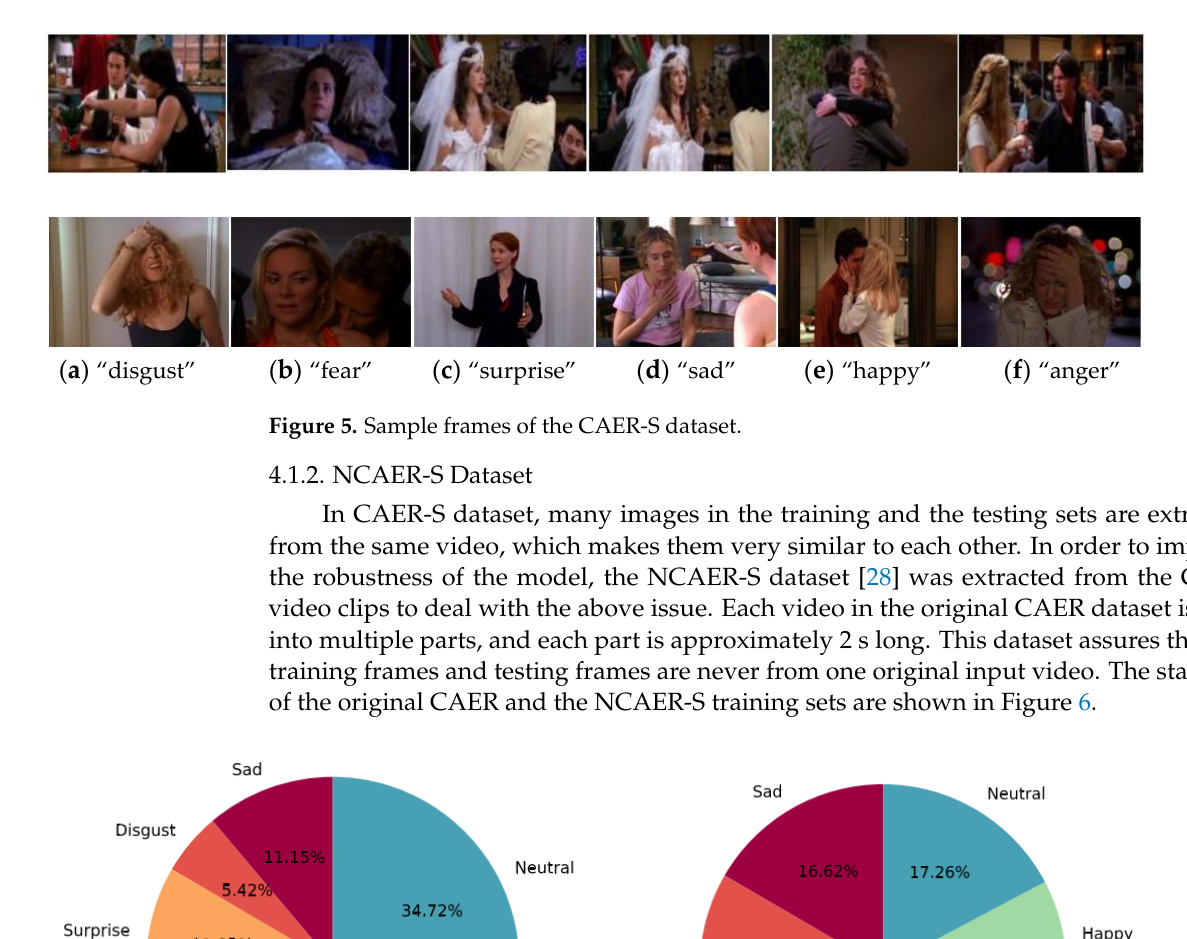
Figure 7. The accuracy curve of MCF-Net on CAER-S dataset. The loss function curve of the MCF-Net obtained during the training process is shown in Figure 8, where the red line represents the training loss, and the blue line means the validation loss. It can be concluded that both training loss and validation loss of our model gradually decrease and begin to converge around the epoch of 30. At the epoch of 45, the curve tends to be stable, and the loss value no longer changes, finally stabilizing at 0.71. The results prove that MCF-Net can better fit the distribution of samples in the train- ing set and the validation set, which verify the rationality of the joint loss at the same time.